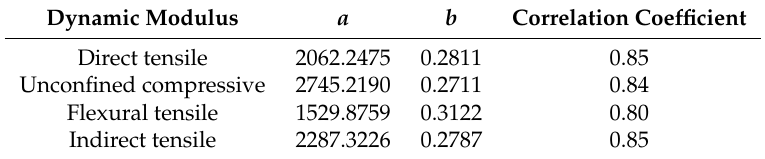
Figure 6. Fitting curve of different dynamic resilient moduli under different loading frequencies. Table 5. Fitting parameters of different dynamic resilient moduli under different loading frequencies.